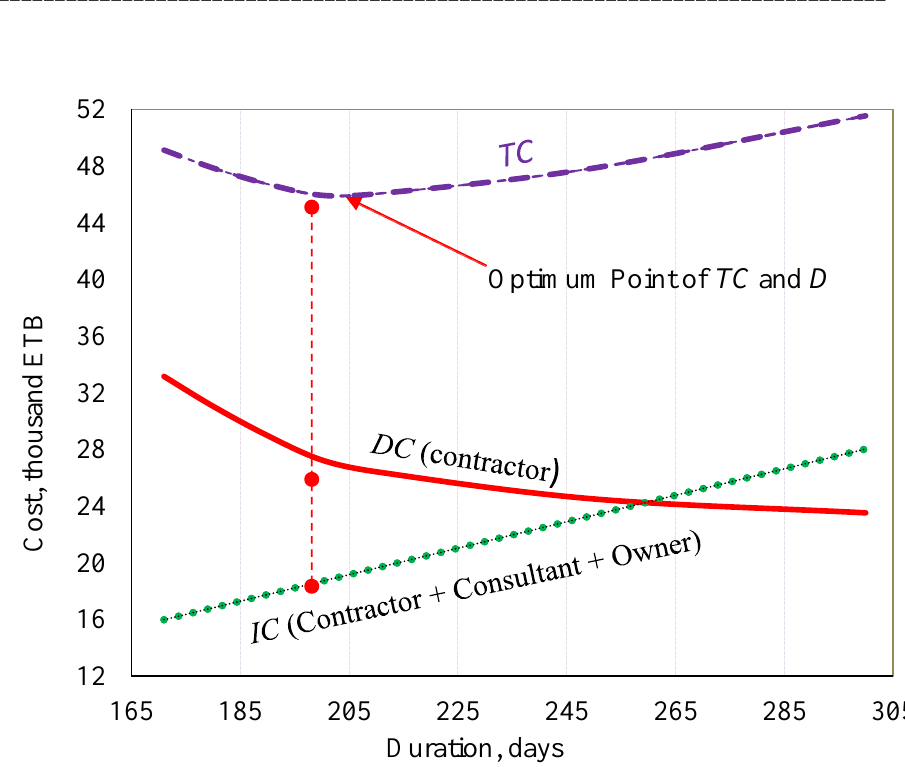
Fig. 1. Time-cost relationship in the construction project, cost in Ethiopian birr (ETB), duration in calendar days (developed by the